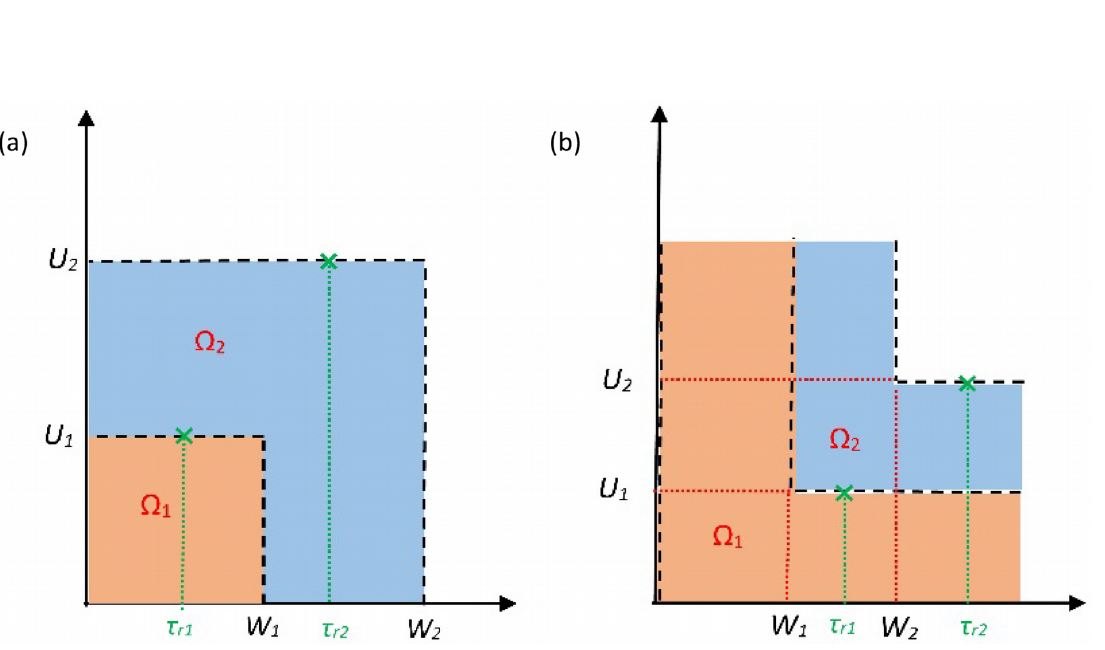
Figure 6. Warranty Regions for Combination Warranty